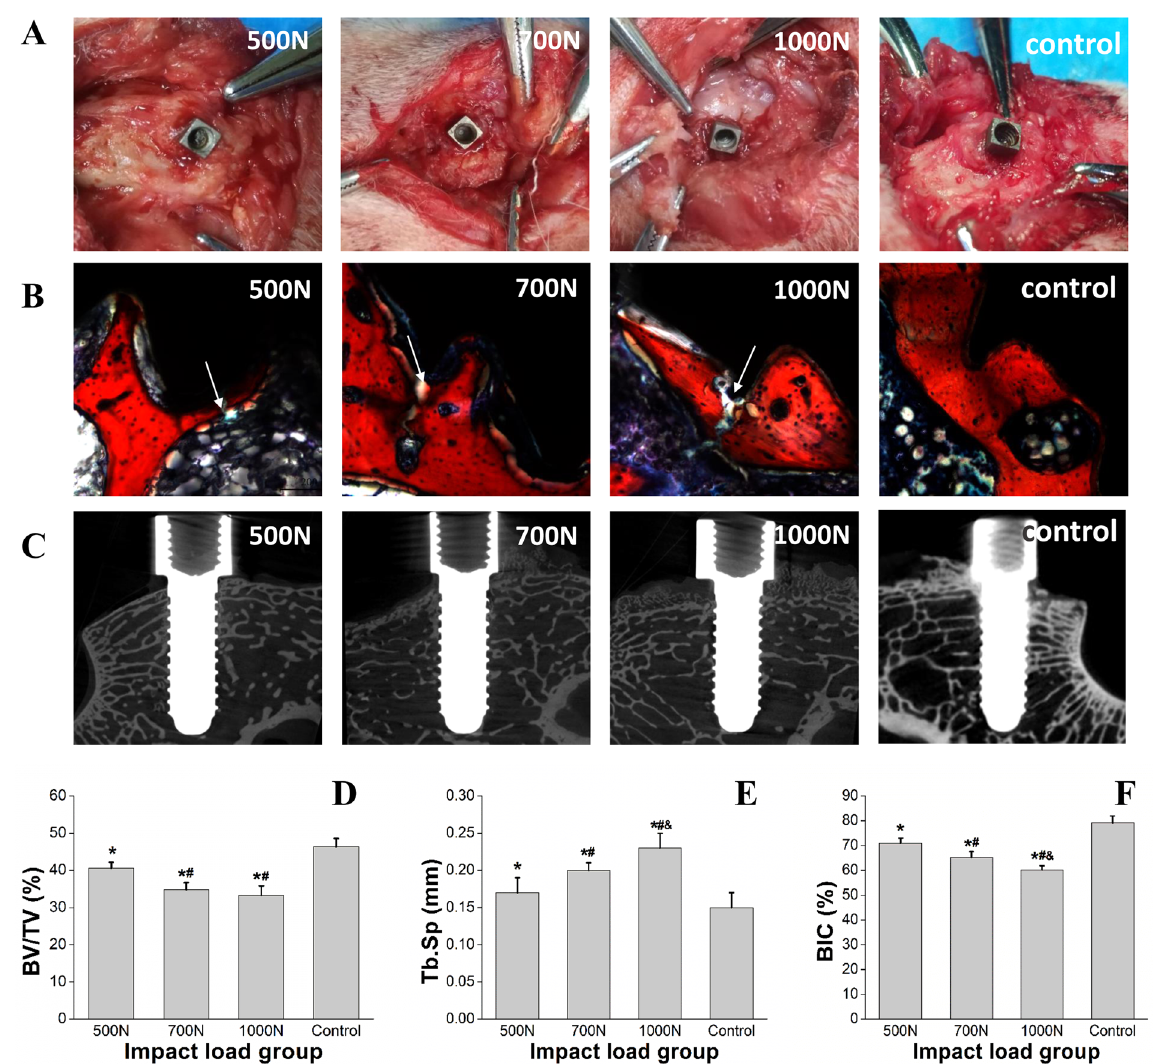
Figure 5. Bone damage caused by the impact in the area surrounding the implant. ( A ) Damage to cortical bone in the area surrounding the implant. ( B ) VG staining showing trabecular bone fracture. ( C ) Micro-CT images showing trabecular bone fracture. ( D ) Data for BV/TV in Micro-CT analysis are expressed as x ± SD (n = 6), and one-way ANOVA was performed with SPSS 19.0. * Indicate significant difference between the test groups and the control group with P < 0.05; # indicate significant difference between the 700N, 1000N group and the 500 group with P < 0.05. ( E ) Data for Tb.Sp are expressed as x ± SD (n = 6), and one-way ANOVA was performed with SPSS 19.0. * Indicate significant difference between the test groups and the control group with P < 0.05; # indicate significant difference between the 700N, 1000N group and the 500N group with P < 0.05; & indicate significant difference between the 1000N group and 700N group with P < 0.05. ( F ) Data for BIC in histological analysis are expressed as x ± SD (n = 6) and one-way ANOVA was performed with SPSS 19.0. * Indicate significant difference between the test groups and the control group with P < 0.05; # indicate significant difference between the 700N, 1000N group and the 500N group with P < 0.05; & indicate significant difference between the 1000N group and 700N group with P <